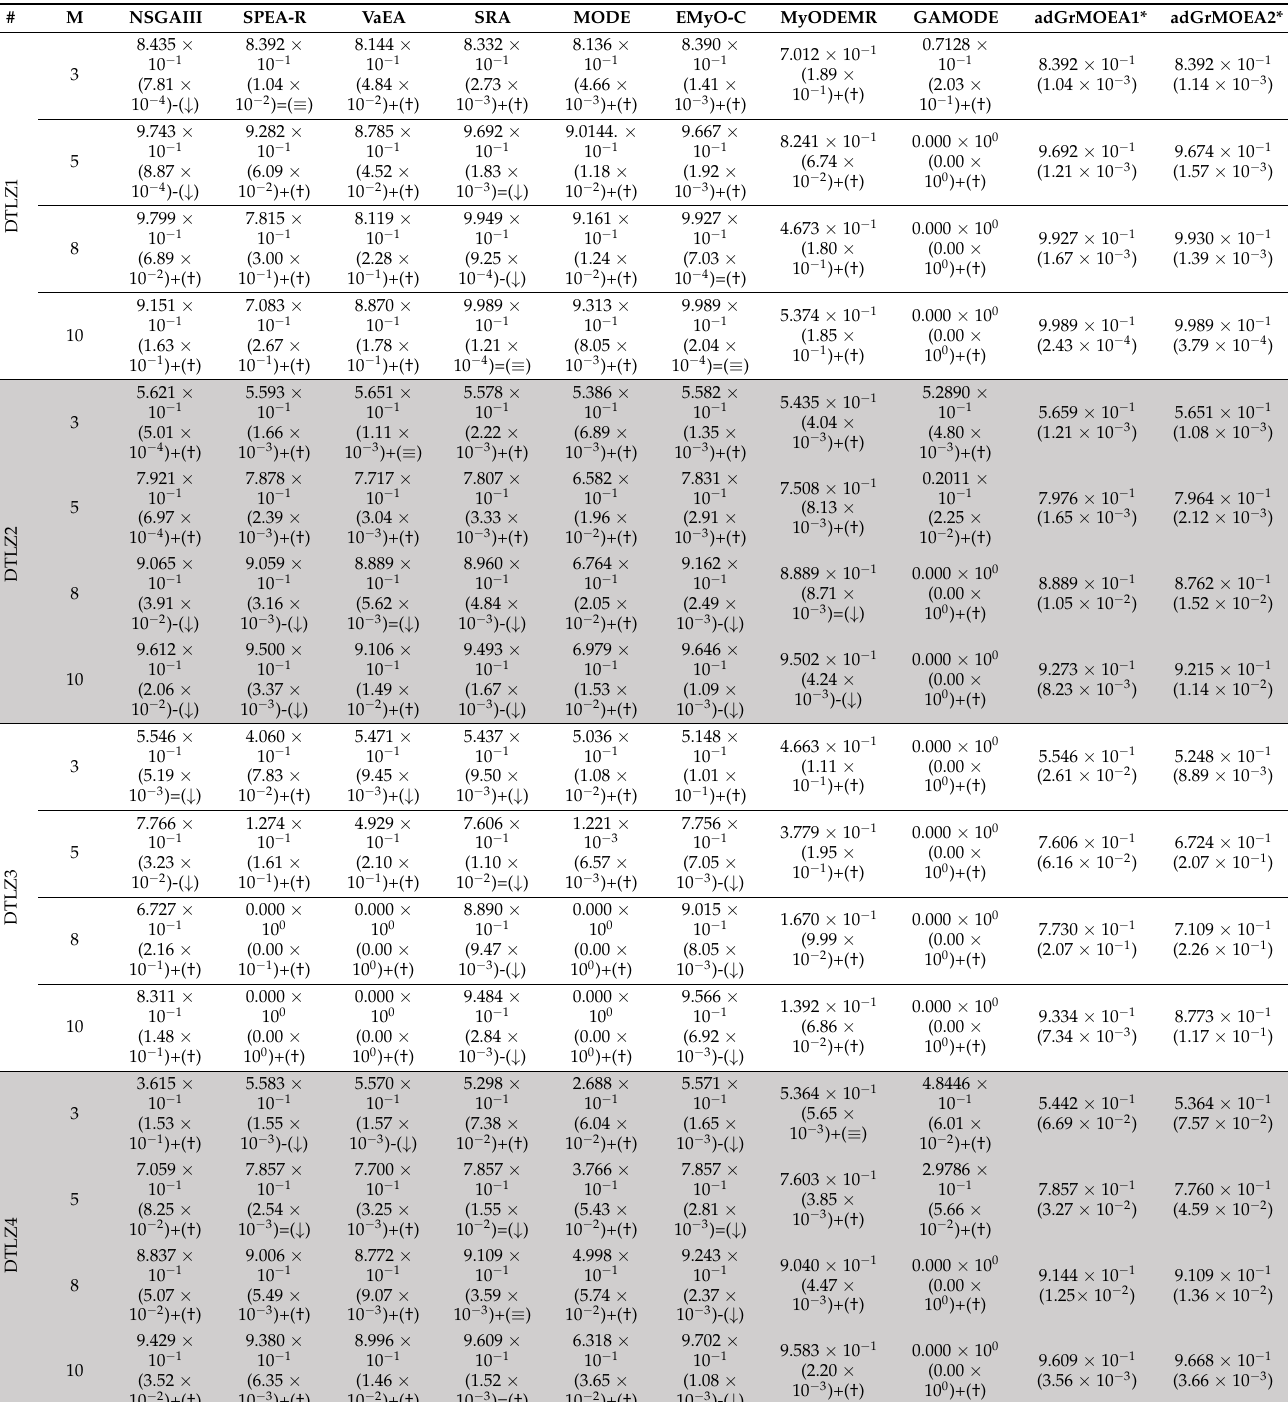
Table A3. Mean and standard deviation values of HV results of proposed method with state of art algorithms on DTLZ